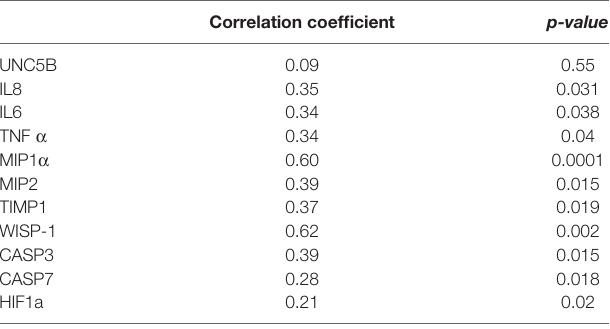
TABLE 2 | Correlation between Granzyme B (GrB) mRNA expression in visceral adipose tissue (VAT) and features of local in fl ammation in obese subjects (n= 85). Correlation coef fi cient